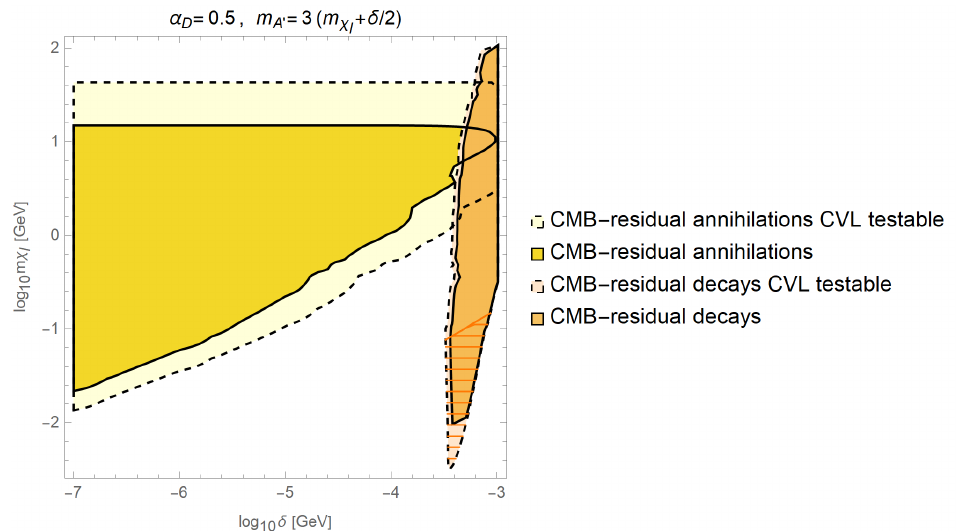
+ δ/ 2) and α = 0 . 5 . Here, and throughout the Figure 5 . Primordial constraints for m A 0 = 3 ( m χ D l rest of the paper, we keep the value of (cid:15) fixed so that we obtain the observed dark matter abundance. The yellow zone in the plot corresponds to cross annihilation cross sections h σ MAX , ann v i > h σ ann v i which is excluded by Planck 2018 data. The light yellow contour shows the maximum region that a cosmic variance limited experiment like Planck would be able to probe. The orange region corresponds to constraints arising from energy release due to decays, and correspondingly the light orange shows the CVL testable region. The striated orange area corresponds to the region where the exclusion can be weakened due to further depletion of the excited state from semi-elastic interactions. Analogous plots for additional dark-sector benchmarks are shown in figure